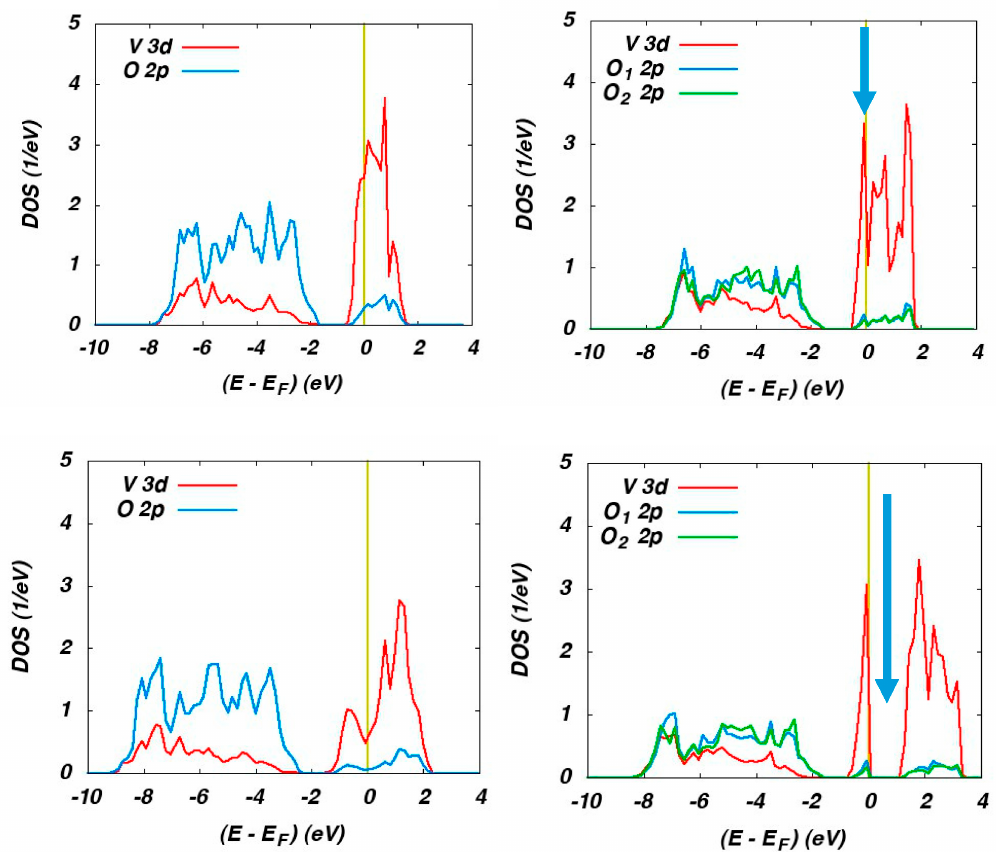
Figure 17. Partial DOS of rutile VO 2 ( left ) and M 1 VO 2 ( right ) as calculated using the GGA ( top ) and the HSE ( bottom ) functional.